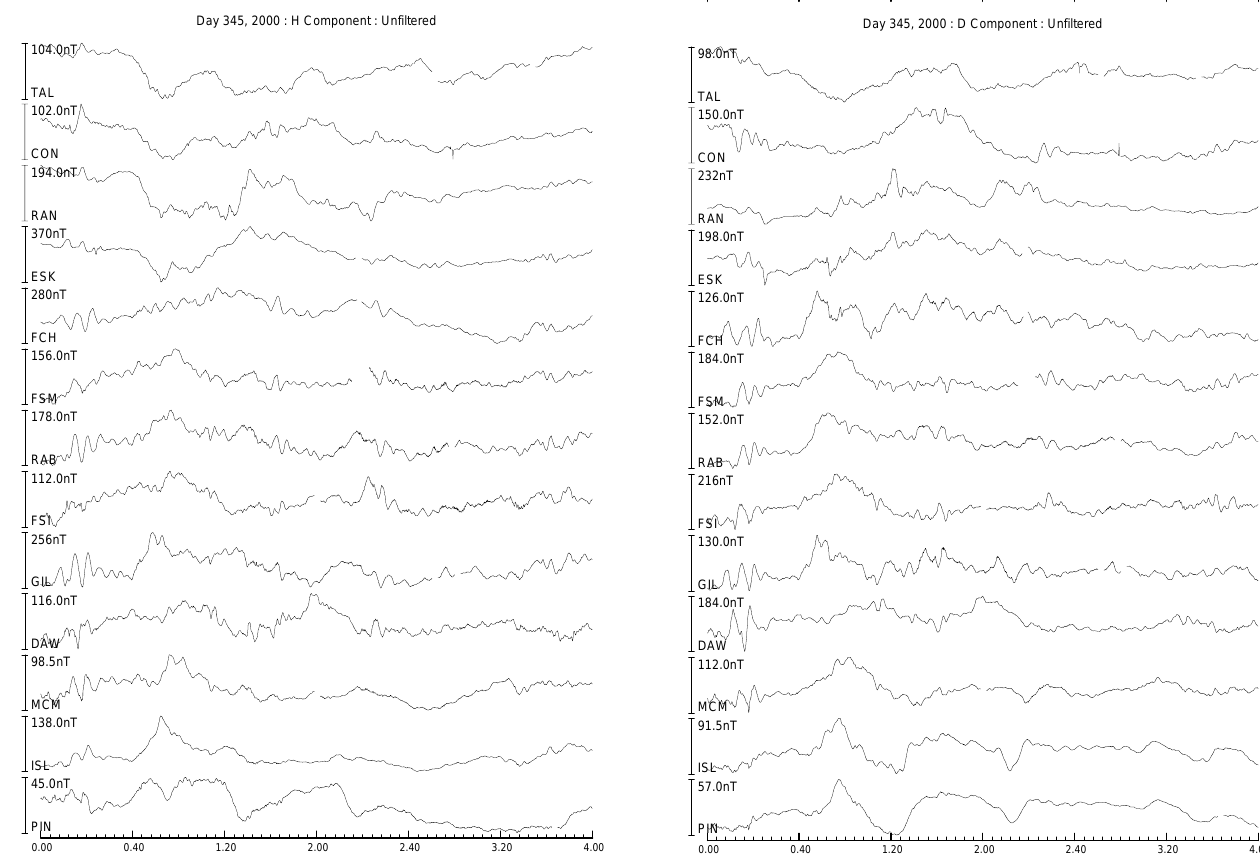
Fig. 2. Stacked raw H (a) and D (b) magnetograms from the CANOPUS magnetometer network between 00:00UT and 04:00UT on 10 December